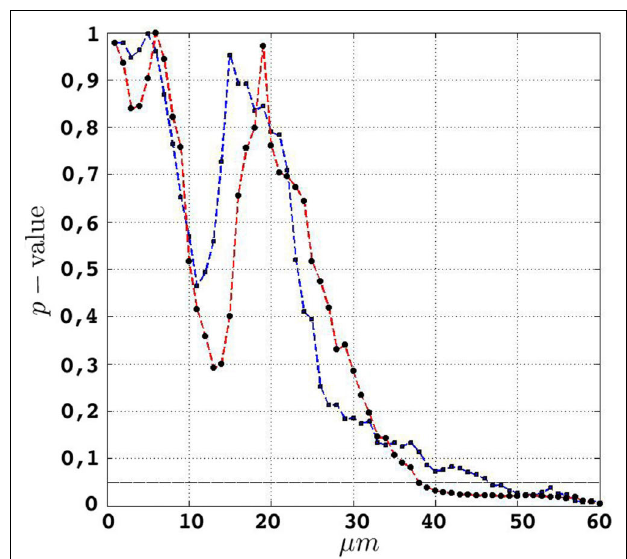
FIGURE 6 | etv (blue) and glt (red) p -values for different values of t . The drop for values larger than 10 µm translates well to cell diameters of 15–20 µm.